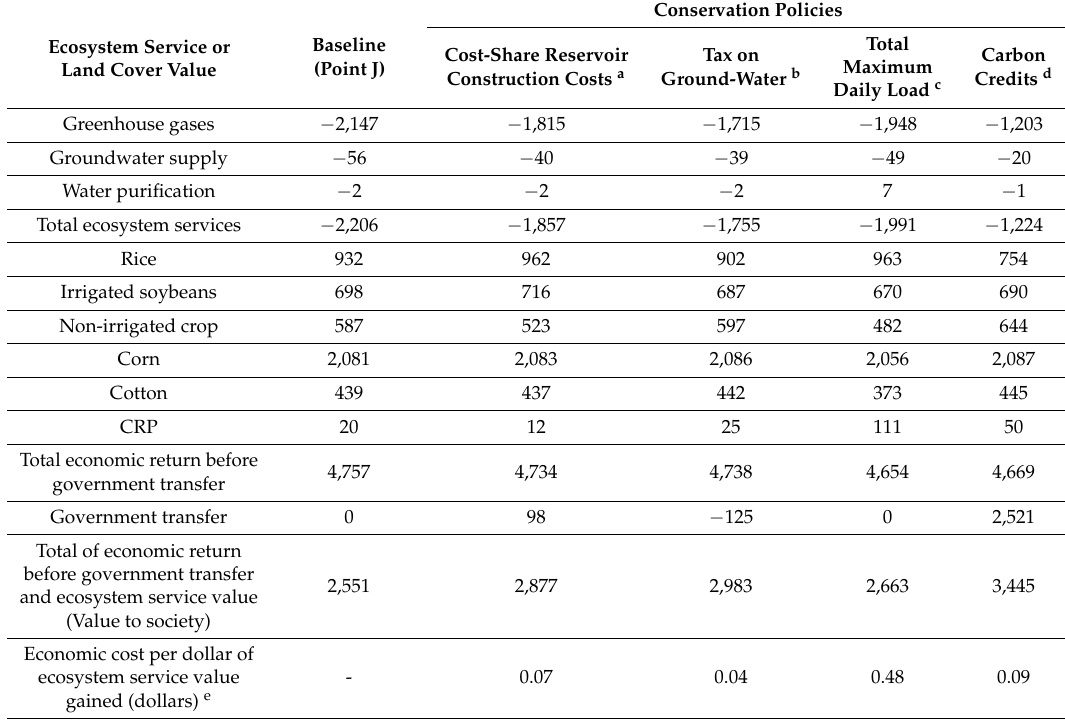
Table 6. Present value of economic returns and ecosystem services that result when conservation policies influence the economic returns objective for the landscape with reservoirs (in millions of 2013 constant